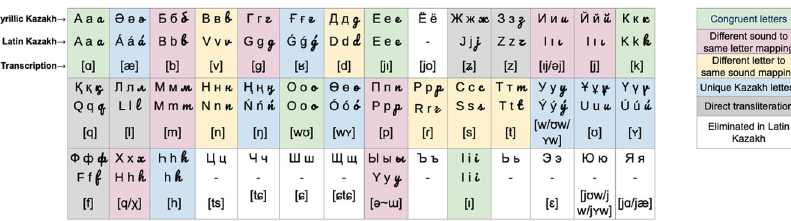
Fig. 1 Similarities and differences between Cyrillic and Latin Kazakh alphabets. Each letter is presented in three forms: print capital, print small, and cursive small forms. Also included the phonetic form of each